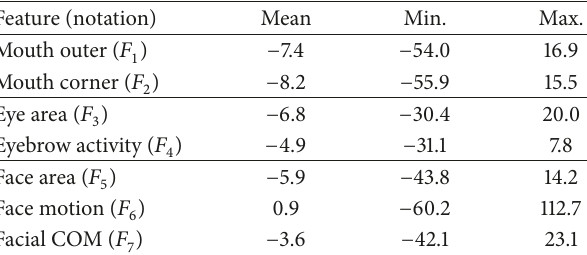
Table 4: Percentage of change of features from period 𝐻 0 to 𝐻 1 in the Platformer game ( 𝑁 = 19 ).